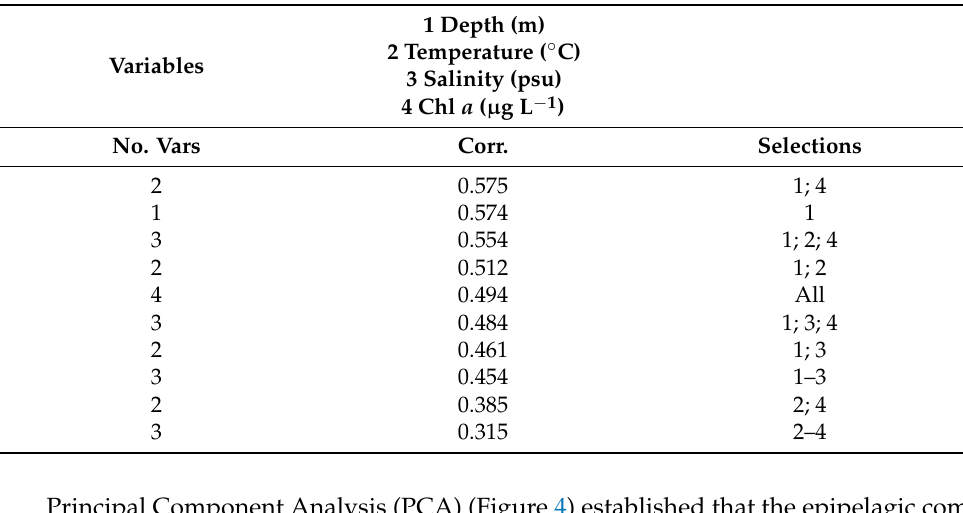
Figure 5. T-S diagram of superficial and deep stations. Color bar shows the depths (m). Not all stations have been indicated at each group (epipelagic and mesopelagic).